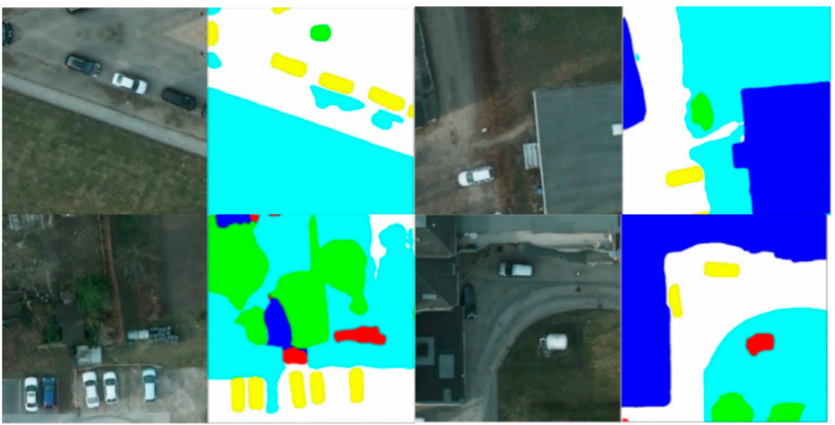
Figure 8. Visualization result of MFNet in the local area of the Potsdam